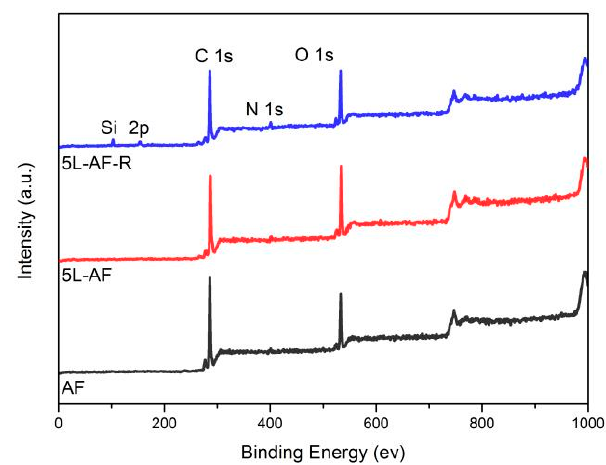
Figure 5. XPS wide-scan spectra of aramid fibers before and after treatment with layer-by-layer self-assembly of L -PDOPA and electrostatic adsorption acidification of silane coupling agents (KH550). Table 3. Surface elements of aramid fibers before and after treatment with layer-by-layer self-assembly of L -PDOPA and electrostatic adsorption acidification of silane coupling agents (KH550).